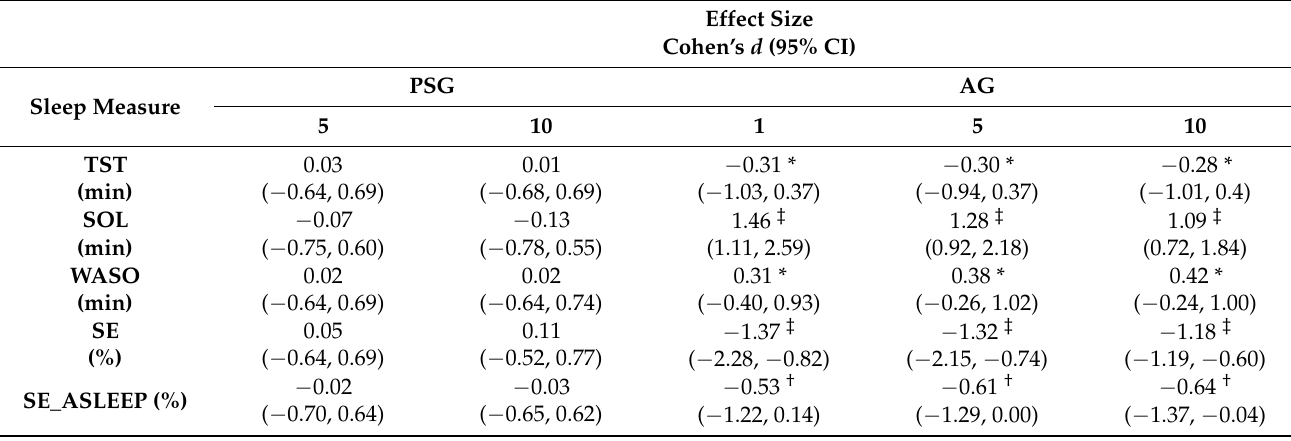
Table 3. Effect of sleep onset rule on sleep